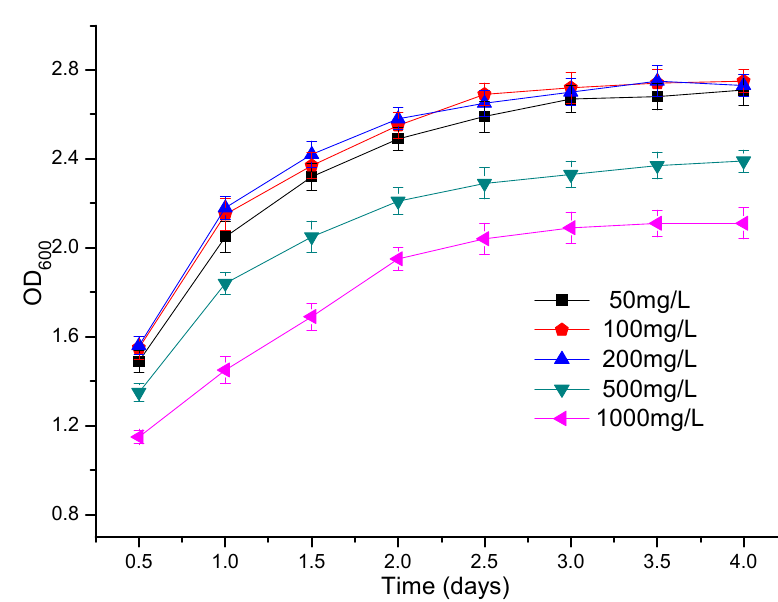
Figure 6. Effect of the concentration of atrazine on the growth of the strain ATLJ-5.